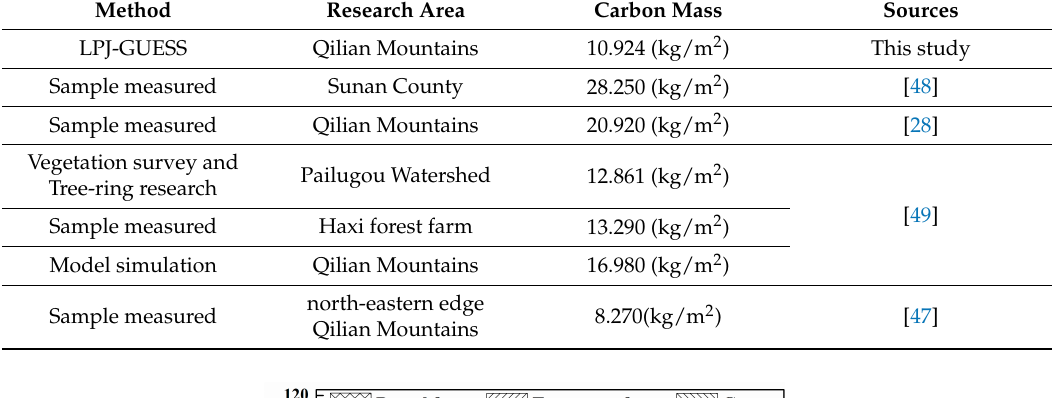
Table 2. Carbon mass calculations for Picea crassifolia in the literature.